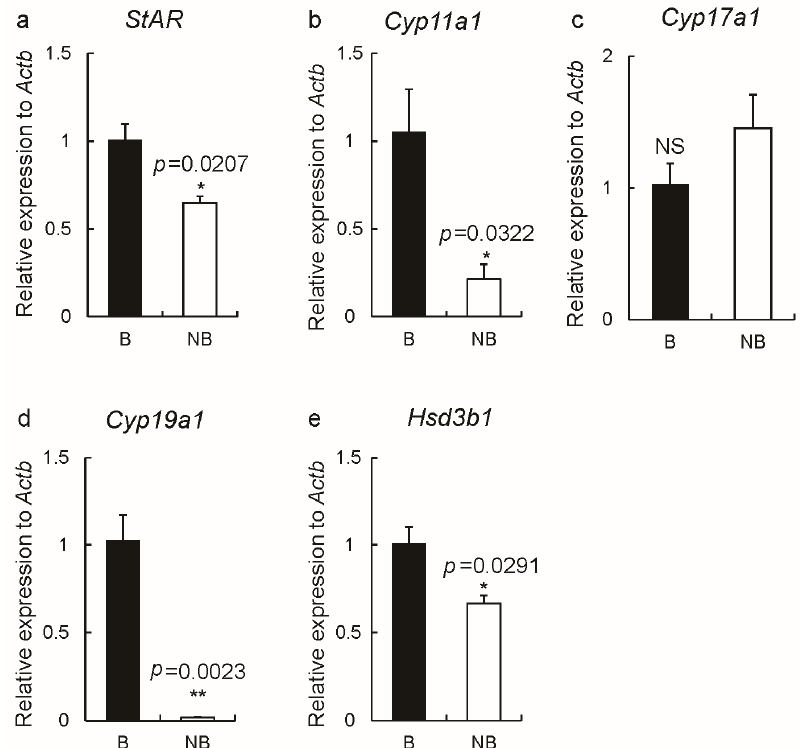
Figure 5. The gene expression levels of Star ( a ), Cyp11a1 ( b ), Cyp17a1 ( c ), Cyp19a1 ( d ), and Hsd3b1 ( e ) in the breeding and non-breeding periods ( n = 3 for each group). Abbreviations: B represents the breeding season; NB represents the non-breeding season. The error bars represent means ± s.e.m. * represented p < 0.05; ** represented p < 0.01; NS represents no significance.